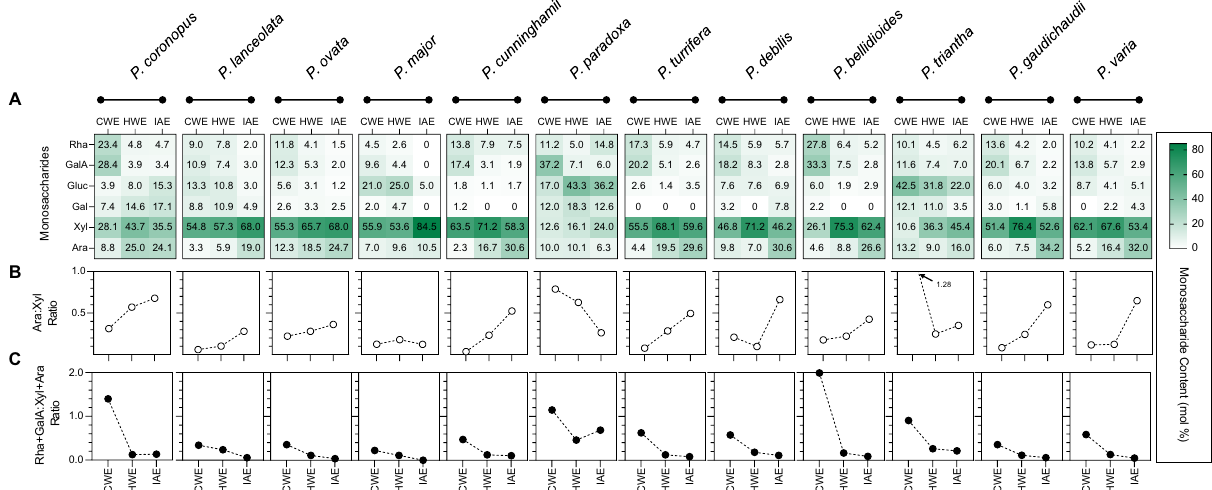
Figure 4. Chemical composition of fractionated mucilage from 12 Plantago species. ( A ) Monosaccharide composition of each mucilage fraction. Heatmap of relative (molar) abundance of each monosaccharide in a fraction. ( B ) Arabinose to xylose (Ara:Xyl) ratio in each fraction. ( C ) Pectin (rhamnose and galacturonic acid) to heteroxylan (xylose and arabinose) (Rha + GalA:Xyl + Ara) ratio in each fraction. CWE = cold water extractable; HWE = hot water extractable; IAE = intense agitation extractable. Values presented are the means of five fractionation ribose, glucuronic acid, and fucose, were minute or not detected (data not shown). The relative abundance of each monosaccharide detected in the mucilage fractions, however, differed significantly. The arabinose to xylose ratio differed interspecifically and also between fractions. In almost all species, the arabinose to xylose ratio rises with increasingly harsh extraction steps (Fig. 4B). In P. paradoxa , the inverse was observed and in the CWE fraction of P. triantha the value was outside the expected range of less than 1 (1.28). These species produced little mucilage and displayed poor monosaccharide recovery which explains some of the discrepancies. In particular, the CWE mucilage fraction from P. triantha was very small and the detected arabinose and xylose are likely not heteroxylan-derived. Values for the more abundant HWE and IAE fractions are within the expected range (< 1). The ratio of rhamnose to galacturonic acid was stable between fractions and differed minimally between species (Fig. 4A). Rhamnose and galacturonic acid, however, were found to be highly-enriched in the CWE fraction of all species (Fig. 4C) but much lower or even absent in subsequent fractions.